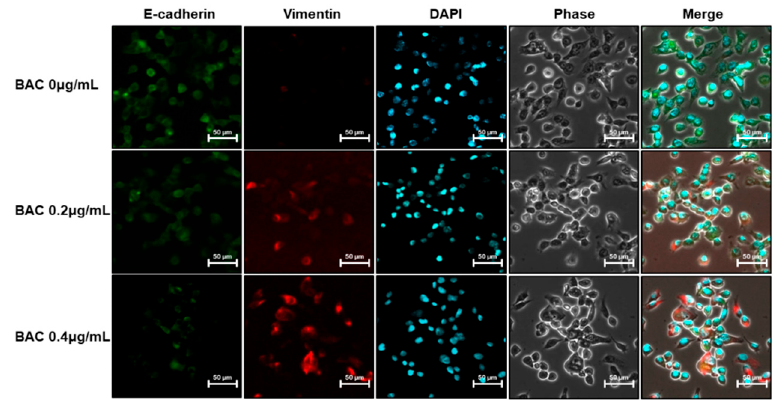
Figure 6. Expression levels of E-cadherin and vimentin in BAC-treated H358 cells. Immunofluorescent staining of E-cadherin (green) and vimentin (red) in H358 cells after incubation of cells with BAC for 21 days. DAPI (blue) is used for nuclear staining. Scale bar, 50 μ m.